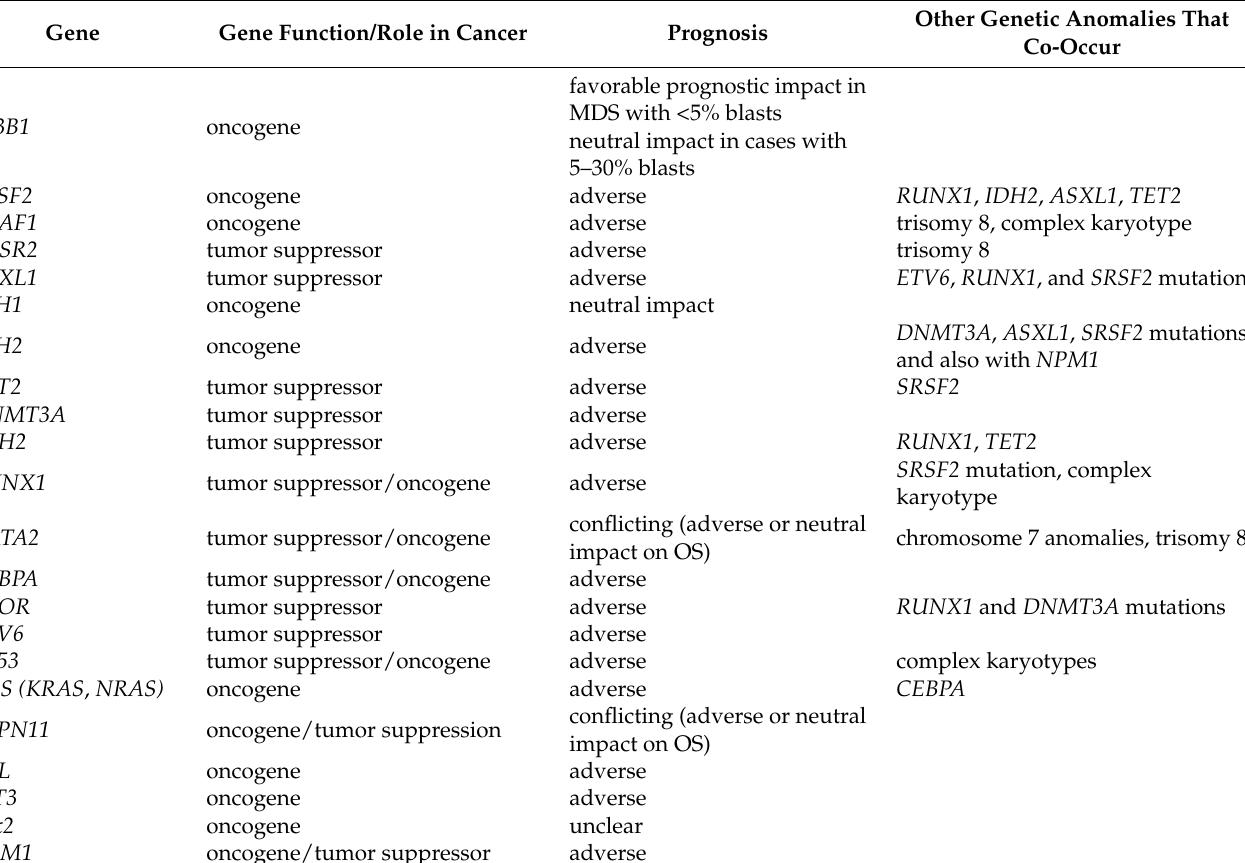
Table 2. Gene mutation in MDS and in progression to